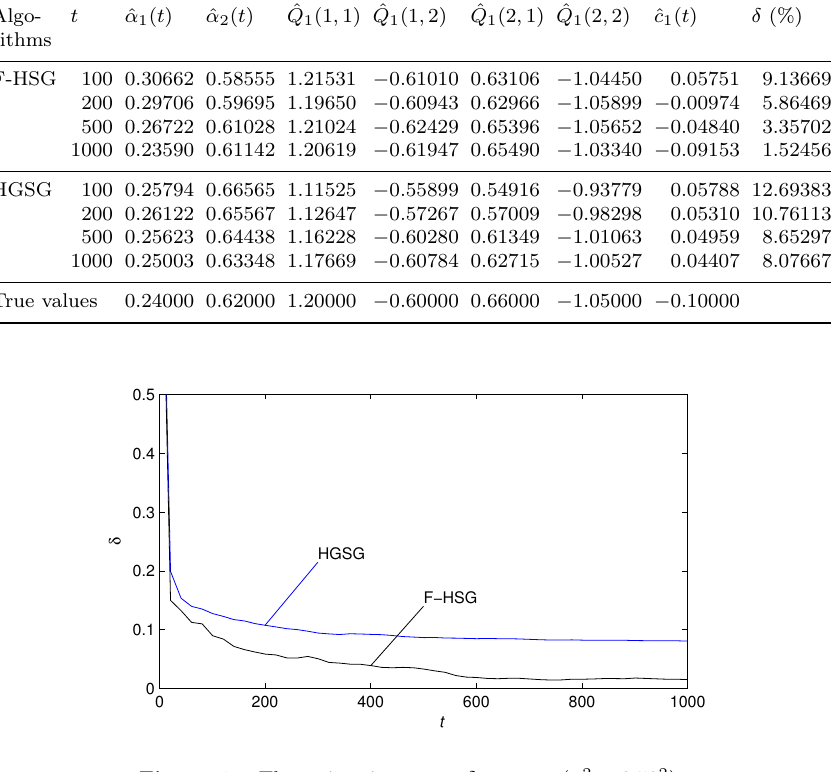
Figure 2. The estimation errors δ versus t ( σ 2 = 0 . 50 2